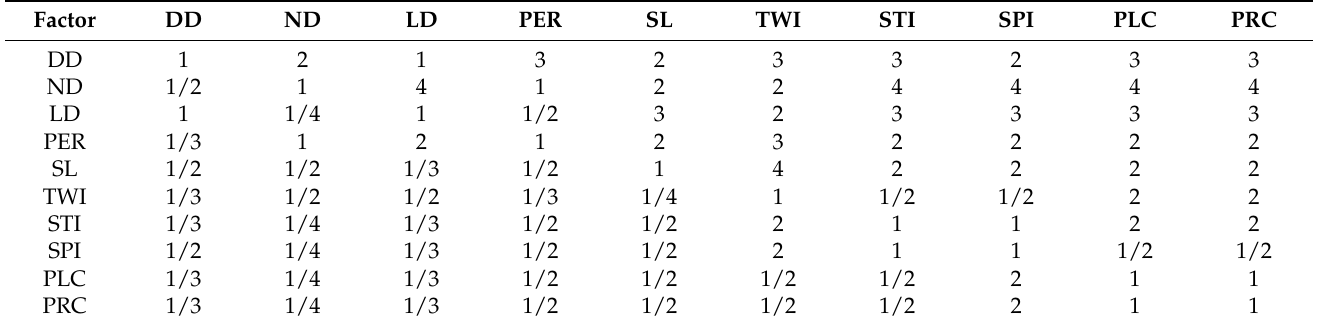
Table 2. Comparison matrix by pair of factors.